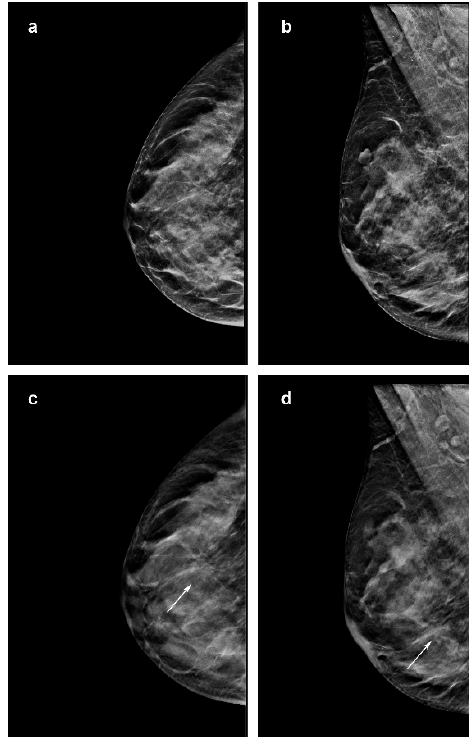
Figure 1. Images of a 56-year-woman with an invasive lobular carcinoma diagnosed at screening digital breast tomosynt 20 mm in the outer inferior quadrant (arrow) ( a–c ). ( d ) It is further less defined in the mediolateral oblique images of the DBT (arrow).